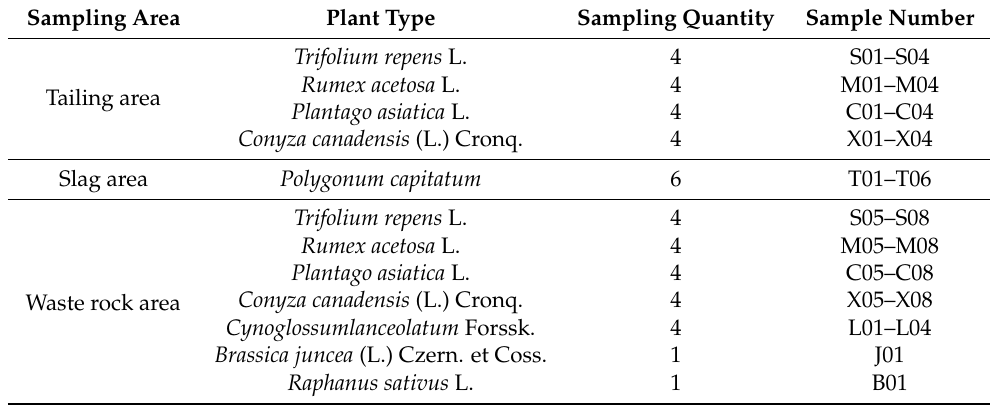
Table 1. Sample collection